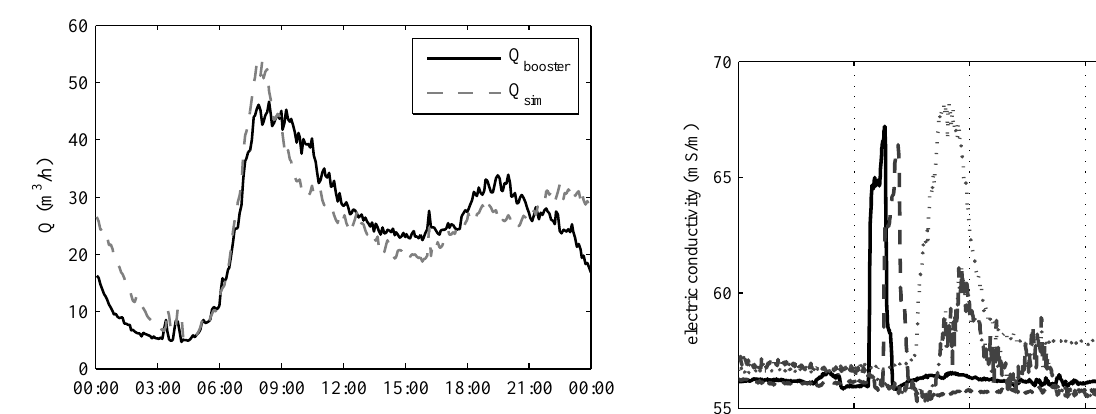
Figure 5. Measured (Q booster ) and simulated (Q SIM from Model BU ) flows on a 5-min time scale.